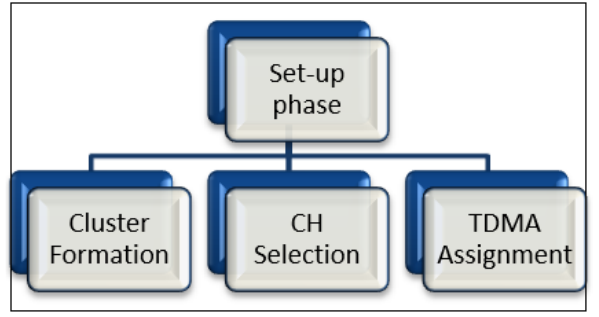
Figure 2. Sensor node’s components.